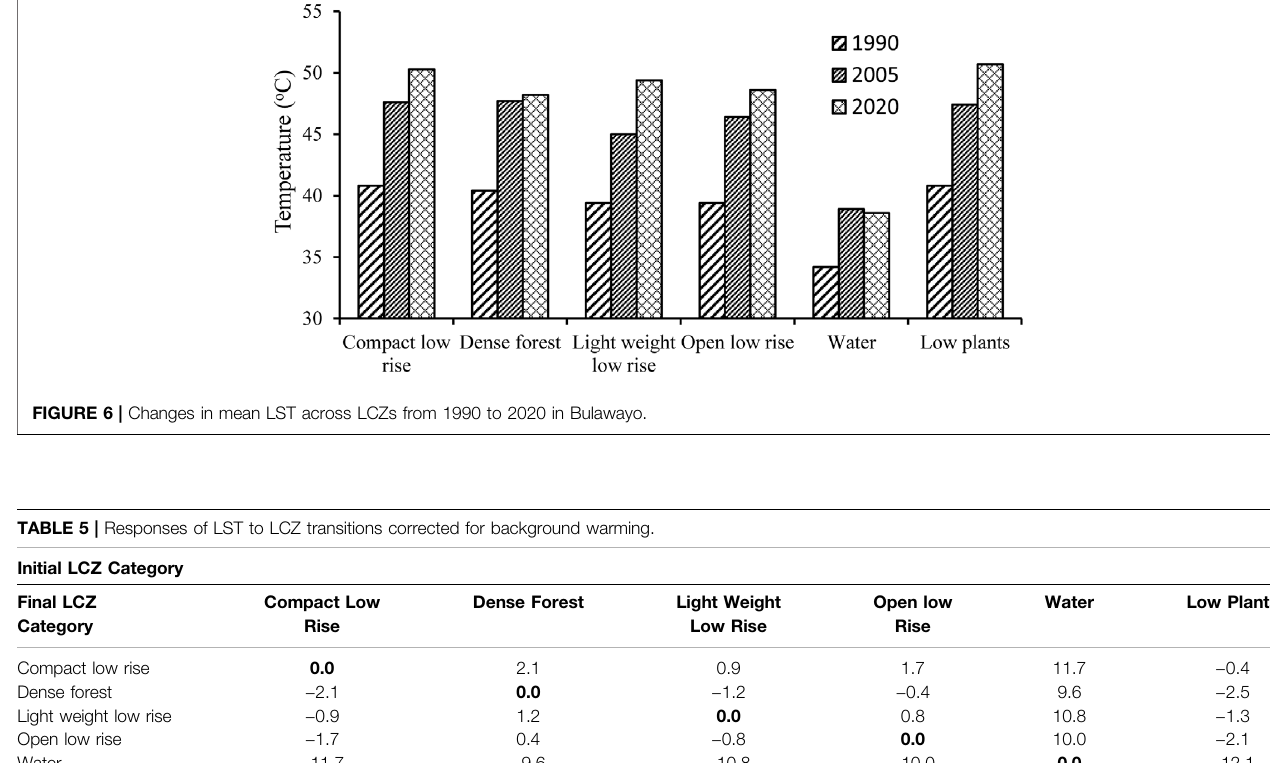
generalization of air temperatures caused by the coarse spatial resolution of the Worldclim data was inadequate for depicting minute temperature structures caused by fragmentation and LCZ heterogeneity in the study area. The details were not as spatially explicit as LST counterparts mapped when using Landsat data